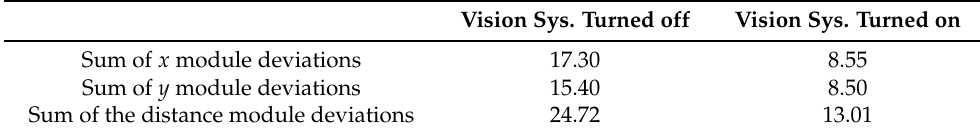
Table 1. The quantitative results comparison of positioning accuracy without and with cameras.